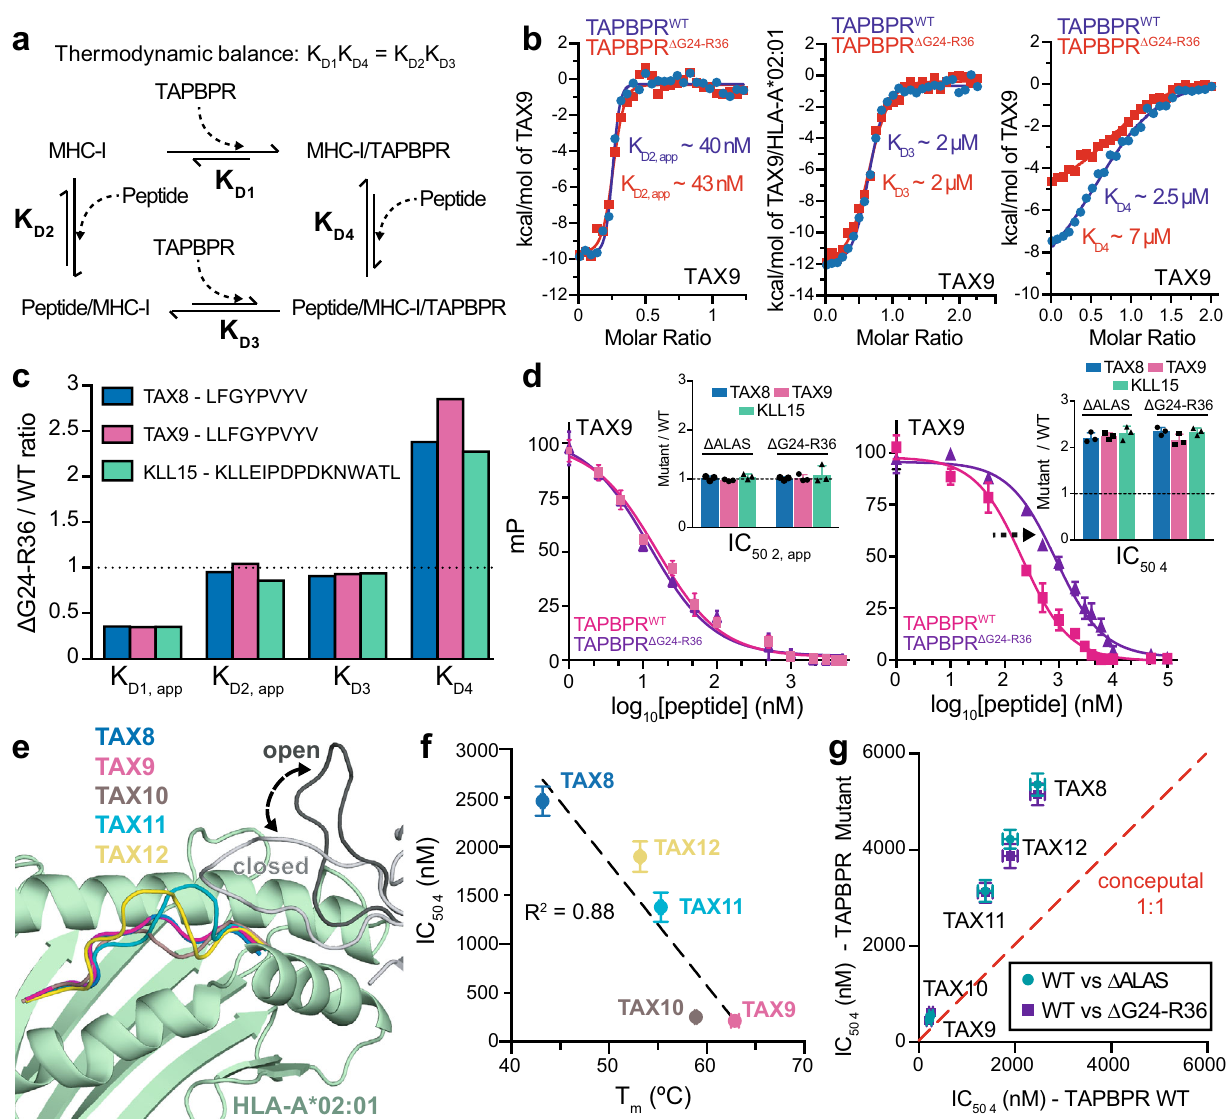
Fig. 5 The TAPBPR G24-R36 loop promotes peptide binding on empty MHC-I. a Schematic of the TAPBPR-mediated MHC-I peptide exchange cycle. The dissociation constant ( K D ) of each step is noted. b ITC performed at different stages of the peptide exchange cycle ( K D2 , K D3 , K D4 ) for TAX9/HLA- A*02:01/h β 2 m with TAPBPR WT or TAPBPR Δ G24-R36 (see “ Methods ” ). K D1 was not measured directly, but inferred from thermodynamic balance along the cycle shown in ( a ). Due to experimental limitations, the measured K D1 and K D2 are “ apparent ” and thus denoted with K D1,app and K D2,app . K D and n values determined by ITC are noted in Table 1. c Apparent K D ratios determined by ITC for TAPBPR Δ G24-R36 /TAPBPR WT for TAX8, TAX9, and KLL15 peptides. The dotted line represents no effect. d FP performed under substoichiometric (left) and stoichiometric (right) conditions. Millipolarization (mP) values are plotted as a function of the log 10 peptide concentration for TAX8, TAX9, and KLL15 competitor peptides. The insets show a comparison of the ratio of FP- determined IC 50 values for TAPBPR Δ G24-R36 or TAPBPR Δ ALAS versus TAPBPR WT . The dotted line represents no effect. e X-ray structures (TAX8, TAX9) and RosettaCM models (TAX10, TAX11, TAX12) show peptide bulging within the HLA-A*02:01 groove. The open and closed conformation of the TAPBPR G24-R36 loop from MD simulations are shown in gray and black, respectively. f Comparison of FP-determined IC 50 values under stoichiometric conditions for TAX length variants versus pMHC-I thermal stability. The R 2 value of the linear regression fi t (black line) is shown. g Comparison of FP-determined IC 50 values under stoichiometric conditions for TAX length variants for TAPBPR WT versus TAPBPR Δ ALAS or TAPBPR Δ G24-R36 . The dotted red line represents a conceptual 1:1 correlation (no effect). Data presented in panels ( d ), ( f ), and ( g ) are mean ± SD for n = 3 independent experimental